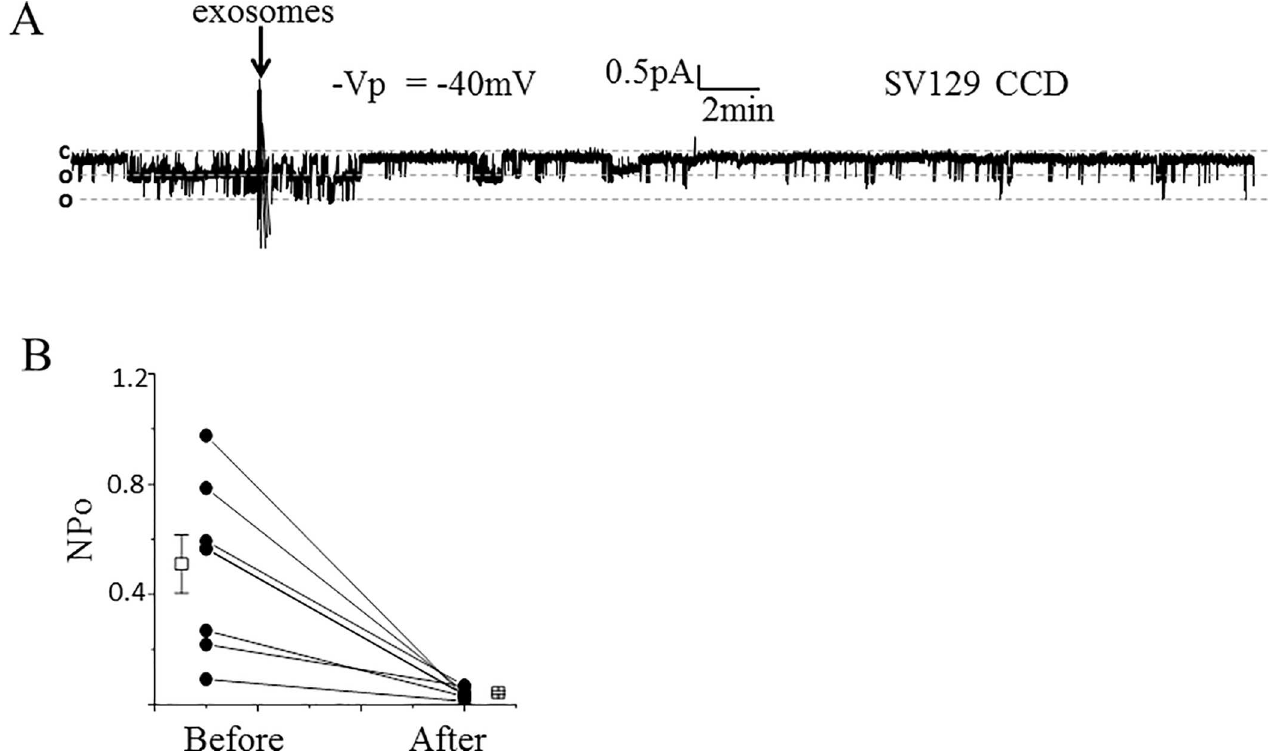
Fig 10. Effect of ENaC activity in freshly isolated split-open tubules from SV129 wild-type mice after application of apical plasma membraneLLC-PK1 exosomes. (A) Representative single-channel recordingshowinga decrease in ENaC activity in native mouse collecting duct cells after application of exosomes isolated from conditionedmedia within the apical side of LLC-PK1 cells. The dashed lines denote open and closed levels (o, open and c, closed). The number of current levels represents the number of channelsin the patch. The arrow indicatesthe time point at which the exosomes were applied. (B) summary line graph showingthe open probability ( P o ) of ENaC decreasedafter applying exosomes isolated from proximal tubule cells. Each point represents the mean ± s.e. and the data shown are from 8 separate patches (N = 8). Two data points are similar and the lines overlap; * P <